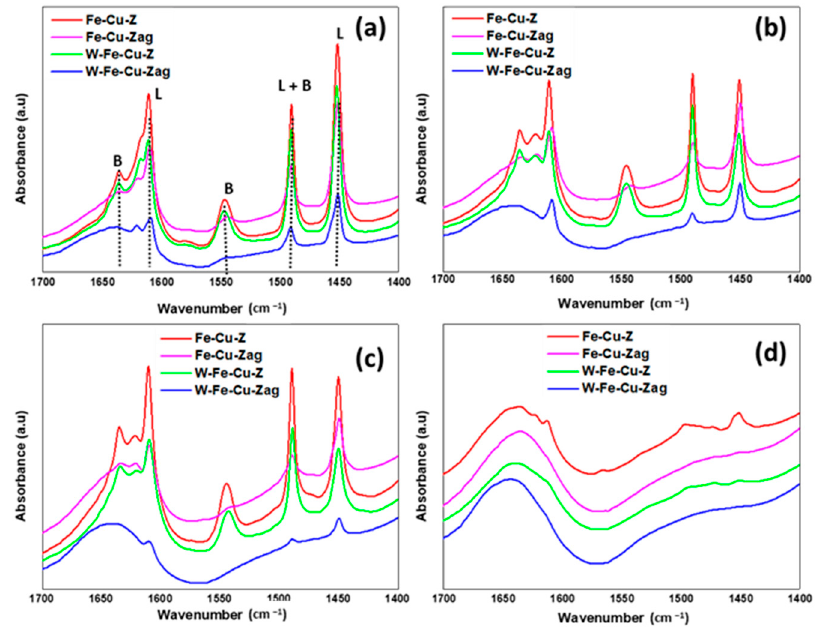
Figure 9. FTIR-Pyr spectra of fresh and aged catalysts degassed at ( a ) 150 °C, ( b ) 250 °C, ( c ) 350 °C, and ( d ) 400 °C.